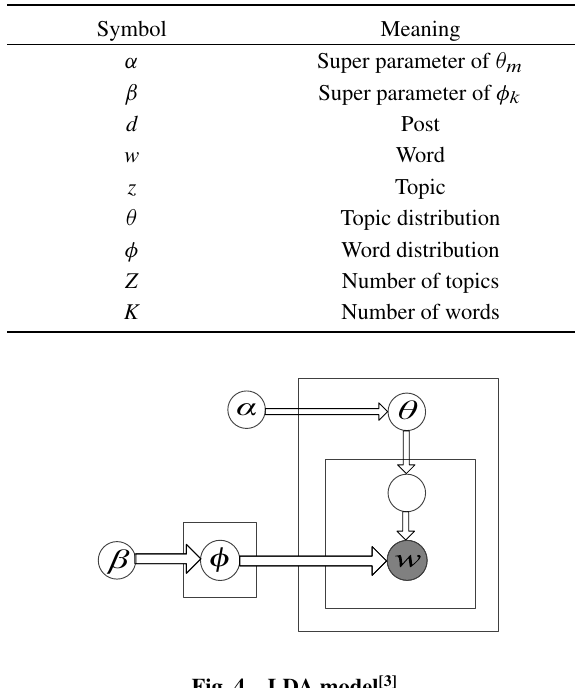
Fig. 4 LDA model [3]